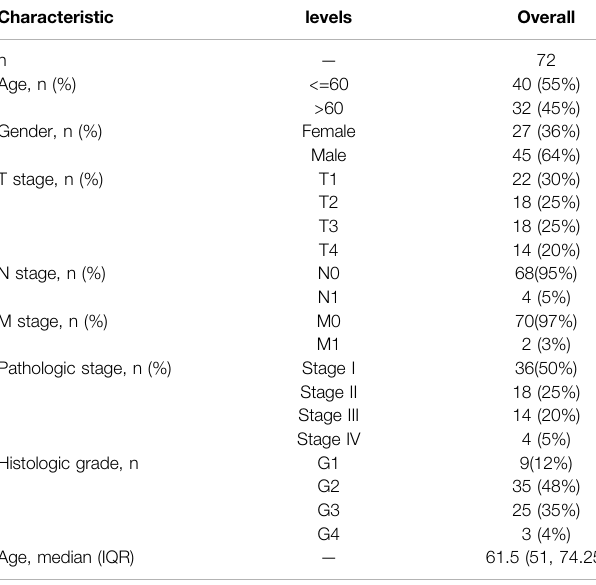
TABLE 1 | Clinical characteristics of the HCC patients used in the derivation cohort. Characteristic Levels